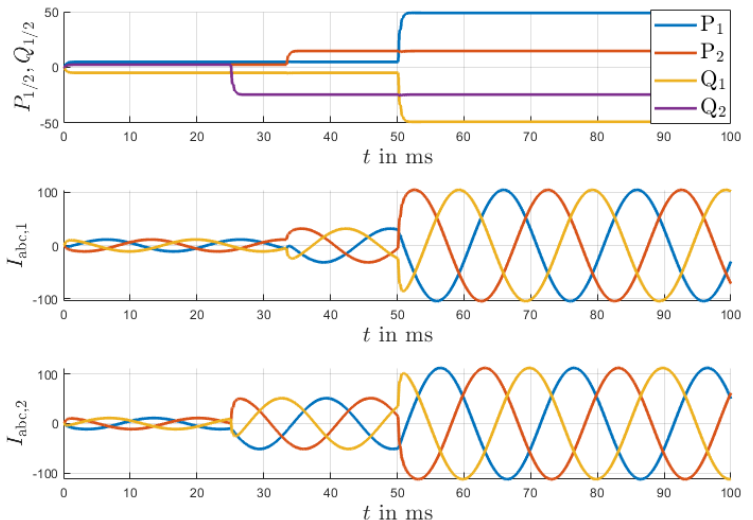
Figure 4. Simulation of the simplified SST inverter model with different realized active and reactive power set-points with G tf being a low-pass filter with a corner frequency of 400 Hz, K p = 1.6, K i = 0.1 × Kp and T s = 100 µ T s